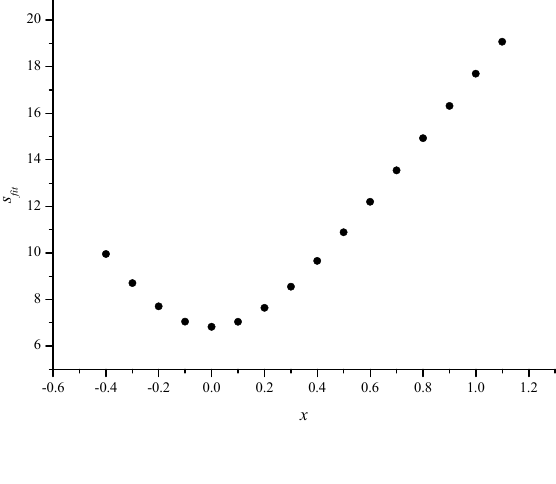
( N )) and x values in fit